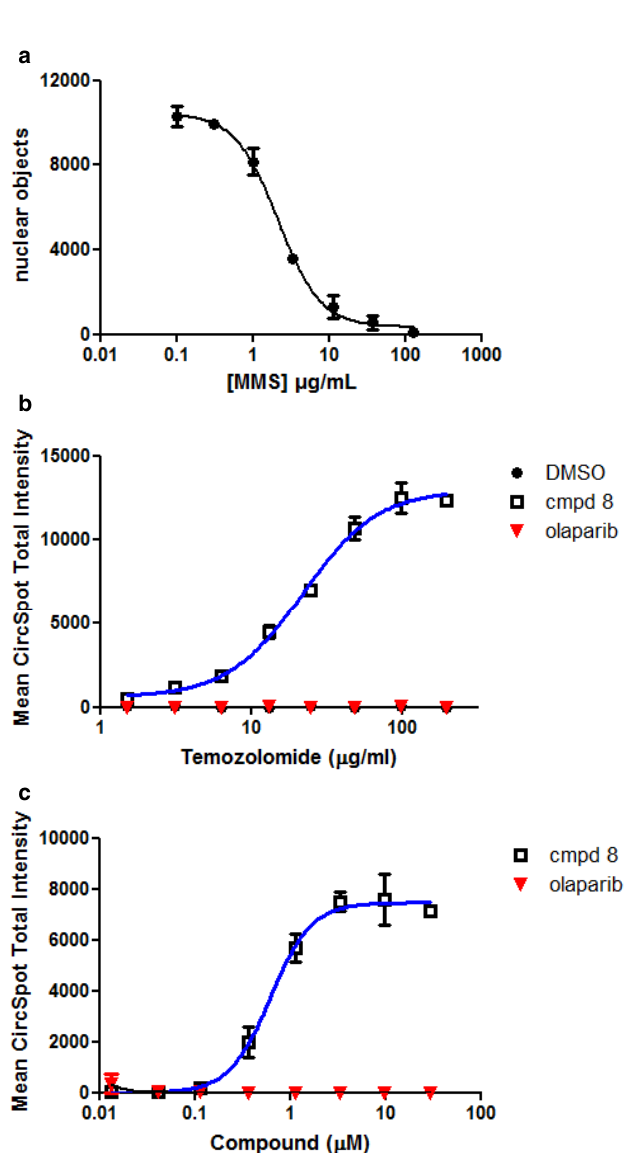
Figure 5. Response of SW620 colorectal cancer cells to alkylating agents. ( a ) SW620 cells treated with MMS for 72 h and stained with Hoechst show a similar dose-dependent decrease in proliferation in comparison with other cell lines tested ( b ) SW620 cells pre-treated with compound 8 at 300 nM increase PAR chains in response to 1 h temozolomide (1.5 µg/mL–200 µg/mL). However, pre-treatment with DMSO or olaparib (300 nM) had no effect on PAR chains at this time point. ( c ) SW620 cells treated with increasing concentrations of a PARG inhibitor (cmpd 8) and 150 µg/mL temozolomide for 1 h showed a dose-dependent increase in PAR chains. As expected at this time point treatment with olaparib had no effect on PAR